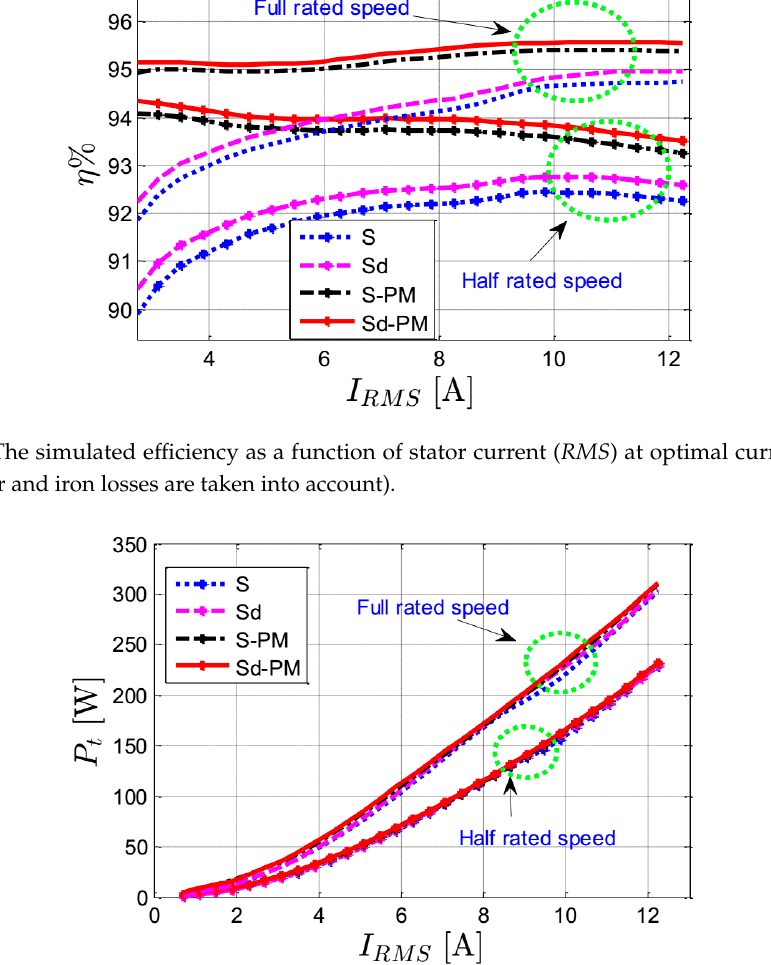
Figure 19. The simulated total losses (copper + iron) as a function of stator current ( RMS ) at optimal current angles.